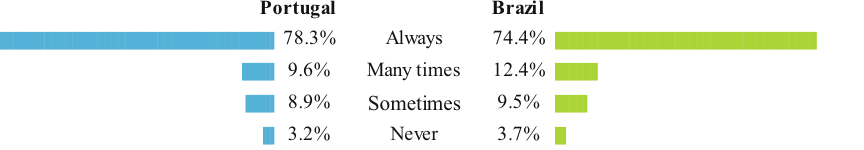
Figure 2: The frequency with which the participants take